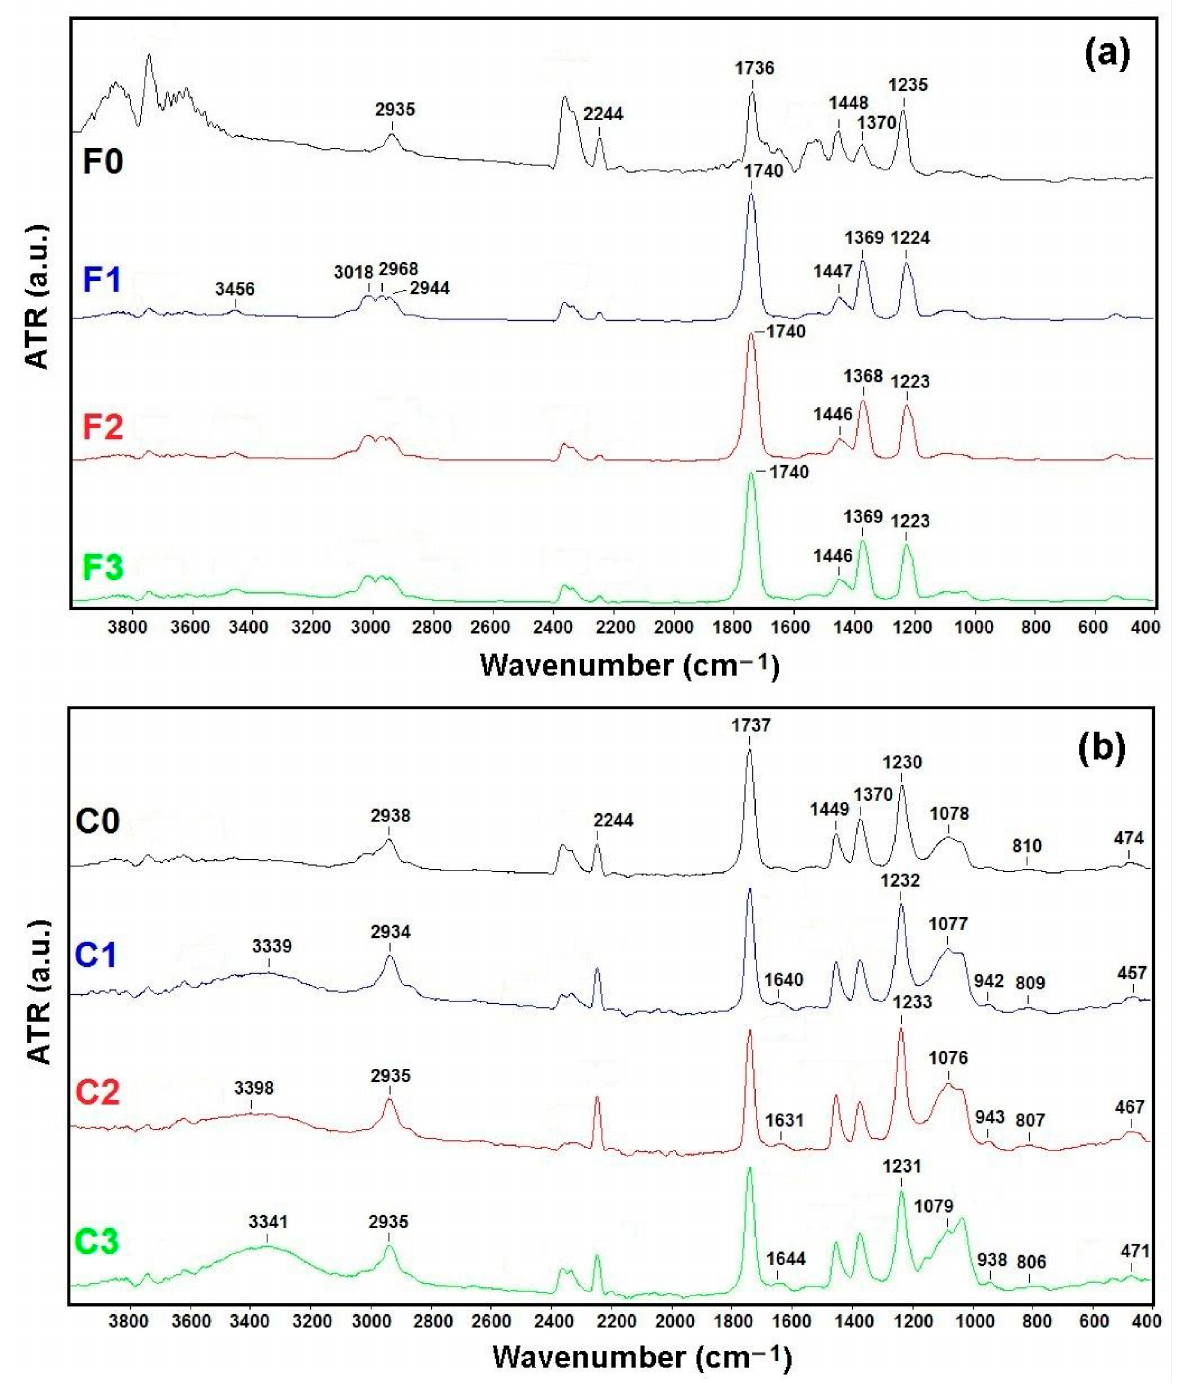
Figure 5. FTIR-ATR spectra for polymeric membranes without ( a ) and with ( b ) SiO 2 nanoparticles, before (F0 and C0) and after (F1–F3 and C1–C3) 1 h of